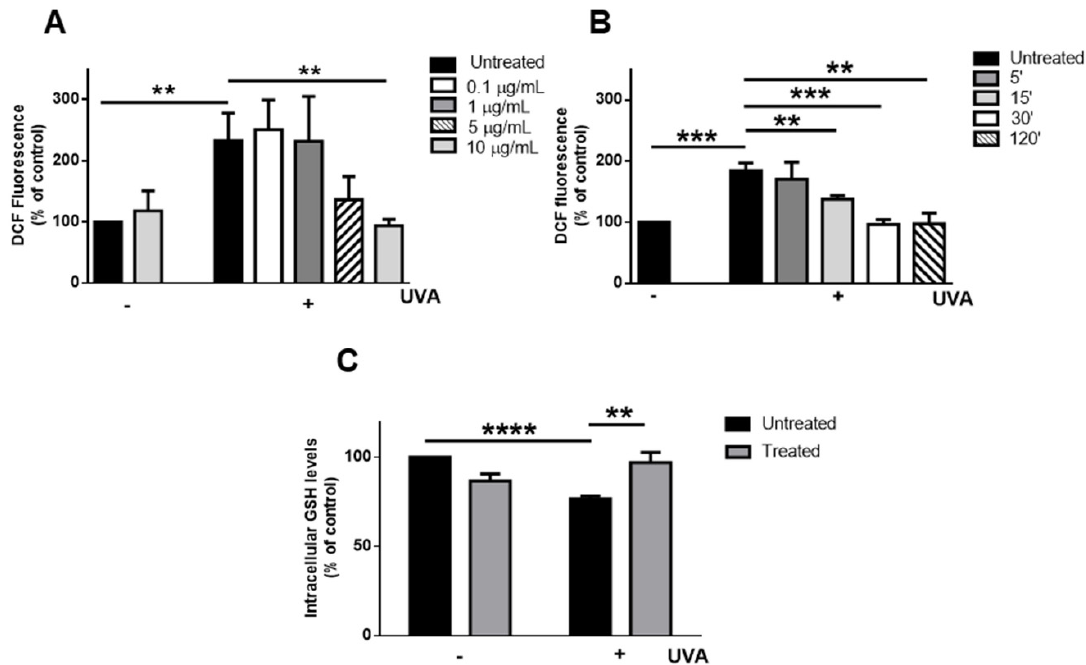
Figure 4. Antioxidant effects of MeDHICA-melanin on UVA-stressed HaCaT cells. ( A ) Dose-response analysis of intracellular ROS levels by 2',7'-dichlorodihydrofluorescein diacetate (H 2 DCFDA) assay. Cells were pre-incubated with increasing concentrations of MeDHICA-melanin for 2 h prior to UVA irradiation (100 J/cm 2 ) for 10 min. Cells were incubated with 0.1 µg/mL (white bars), 1 µg/mL (dark grey bars), 5 µg/mL (dashed bars) or 10 µg/mL (light grey bars) MeDHICA-melanin. Black bars refer to untreated cells. ( B ) Time-course analysis of intracellular ROS levels by H 2 DCFDA assay. Cells were incubated for 5 min (dark grey bars), 15 min (light grey bars), 30 min (white bars) or 120 min (dashed bars) with MeDHICA-melanin before being irradiated by UVA. Black bars are referred to untreated cells. ( C ) Intracellular GSH levels evaluated by 5,5 ′ -dithiobis-2-nitrobenzoic acid (DTNB) assay. Cells were pre-incubated with MeDHICA-melanin (10 µg/mL) for 1 h before UVA irradiation. Values are expressed as % with respect to control (i.e. untreated) cells. Data shown are means ± SD of three independent experiments. ** indicates p < 0.005, *** indicates p < 0.0005, **** indicates p < 0.0001.